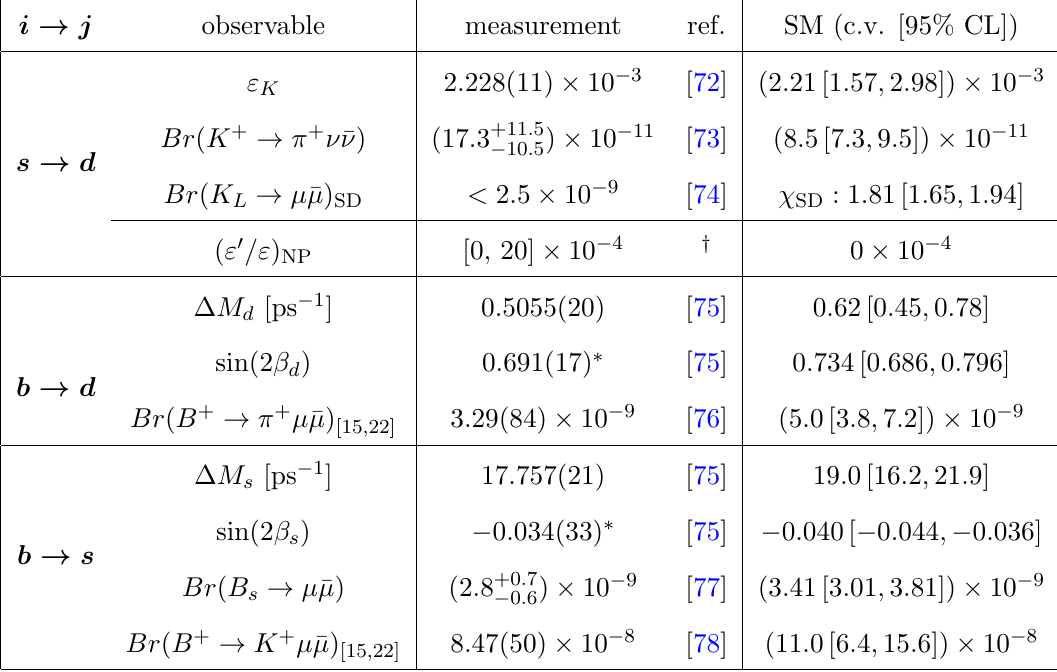
Table 8. The list of (cid:1) F = 2 ; 1 (cid:13)avour observables in i j down-type transitions that are used j j ! to constrain the VLQ couplings. SM predictions are obtained with CKM parameters determined from the tree-(cid:12)t. y We impose this conservative range on the NP contribution of " 0 =" to avoid values excluded by this observable in the predictions for other observables, see text for more details.